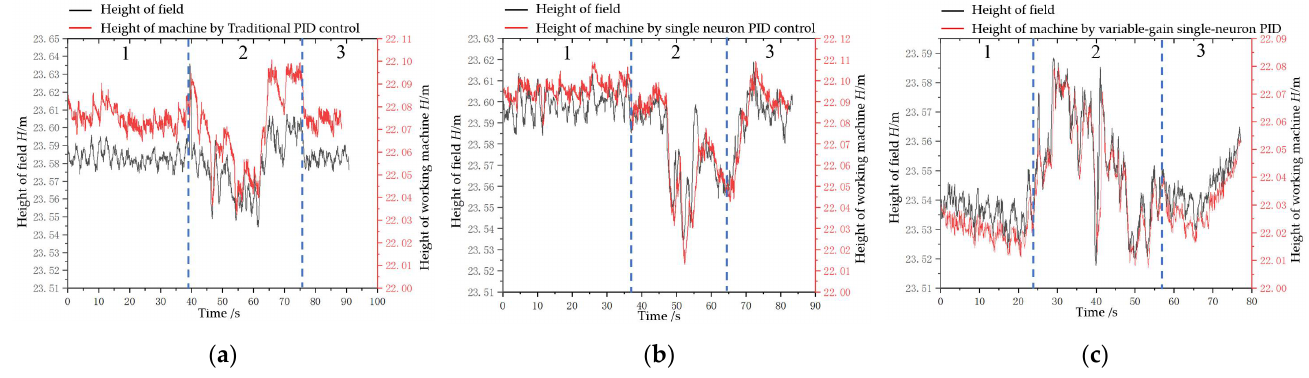
Figure 13. Effects of rotary burying heights following surface changes under three algorithms. ( a ) Results of conventional PID control; ( b ) Results of single neuron PID; ( c ) Results of variable-gain single-neuron PID. Note: area 1 is a flat area at the head of the field, area 2 is an area with surface unevenness in the field, and area 3 is a flat area at the end of the field.